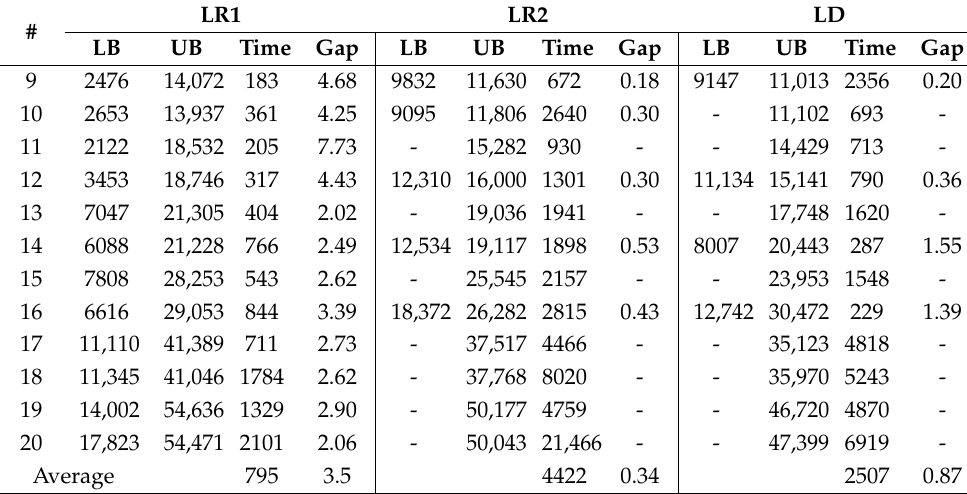
Table 10. Calculation results to compare the bounds for LR1, LR2, and LD.